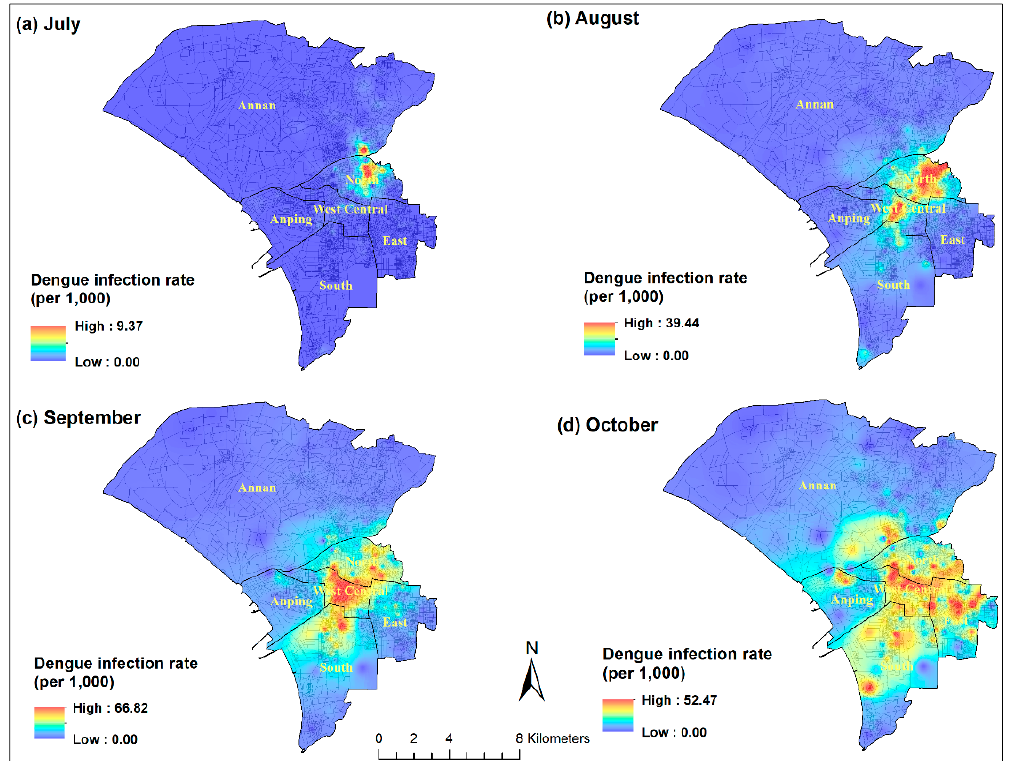
Figure 4. Monthly spatial distributions of dengue incidence rates (BSA level) in Tainan City during the outbreak season.